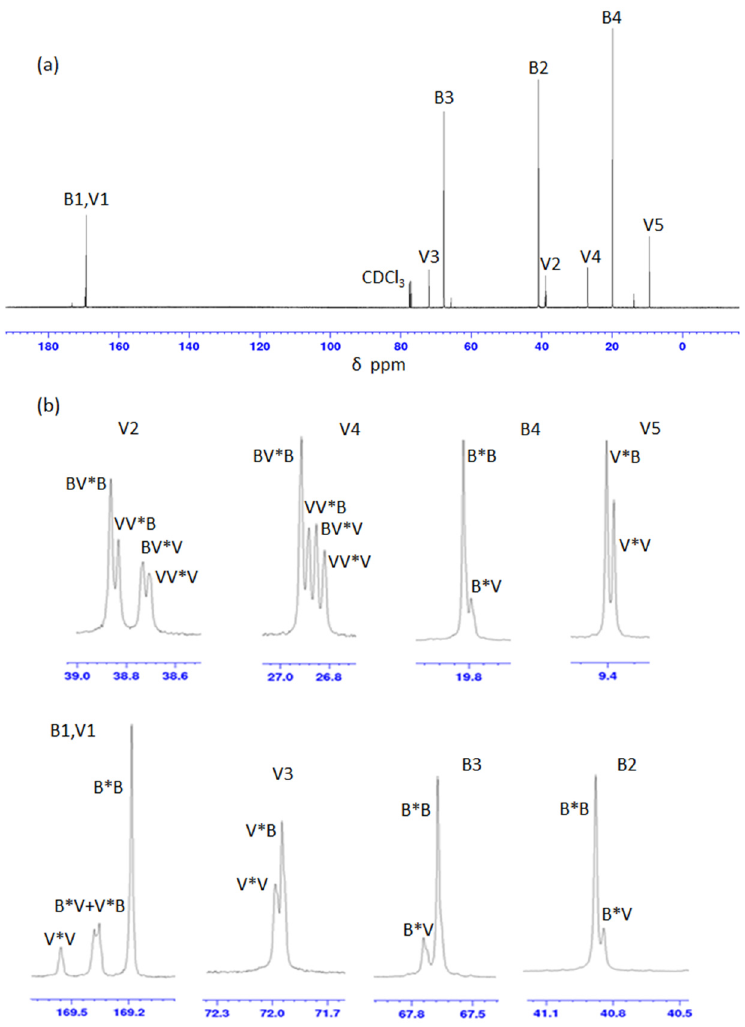
Figure 2. 13 C-NMR ( a ) full spectrum; ( b ) expanded region associating to the splitting of individual resonances of PHBV-61. * denotes linkage between units V and B.